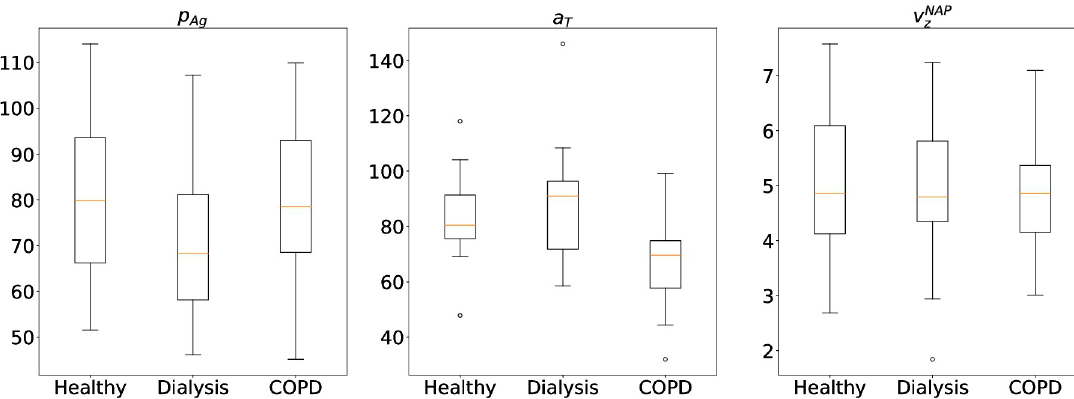
Fig 2. Boxplot of the MAP estimates of the biologically meaningful discriminating parameters grouped according to patient types. Healthy: Healthy volunteers (16 patients); Dialysis: All Patients undergoing dialysis (16 patients); COPD: Patients with COPD (16 patients). The box in the plot extends from the first quartile (Q1) to third quartile (Q3) of the estimated parameters for each type of patients, with an orange horizontal line at the median. The upper whisker extends to the largest value less than Q3 + 1.5 � IQR and the lower whisker extends to the lowest value greater than Q1 − 1.5 � IQR, where IQR is the interquartile range (Q3-Q1). Beyond the whiskers, any values are considered outliers and are plotted as individual